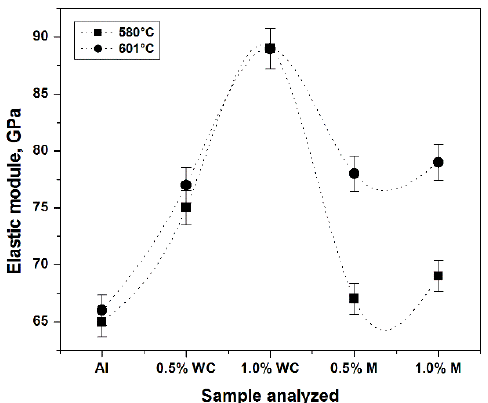
Figure 7. Results of the elastic modulus evaluated in the samples with different compositions and sintered at different